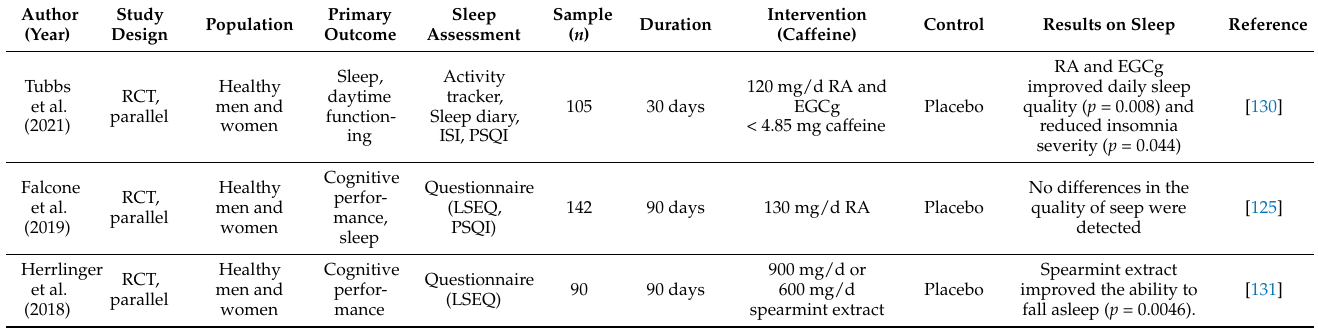
Table 3. Summary of human clinical studies assessing the association between sleep and RA con-